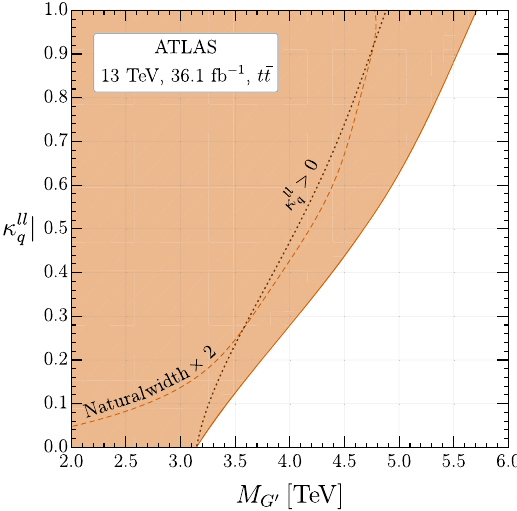
correspond to κ ll q < 0 with the natural width and twice the natural width, respectively. The dashed line denotes the exclusion region for κ ll